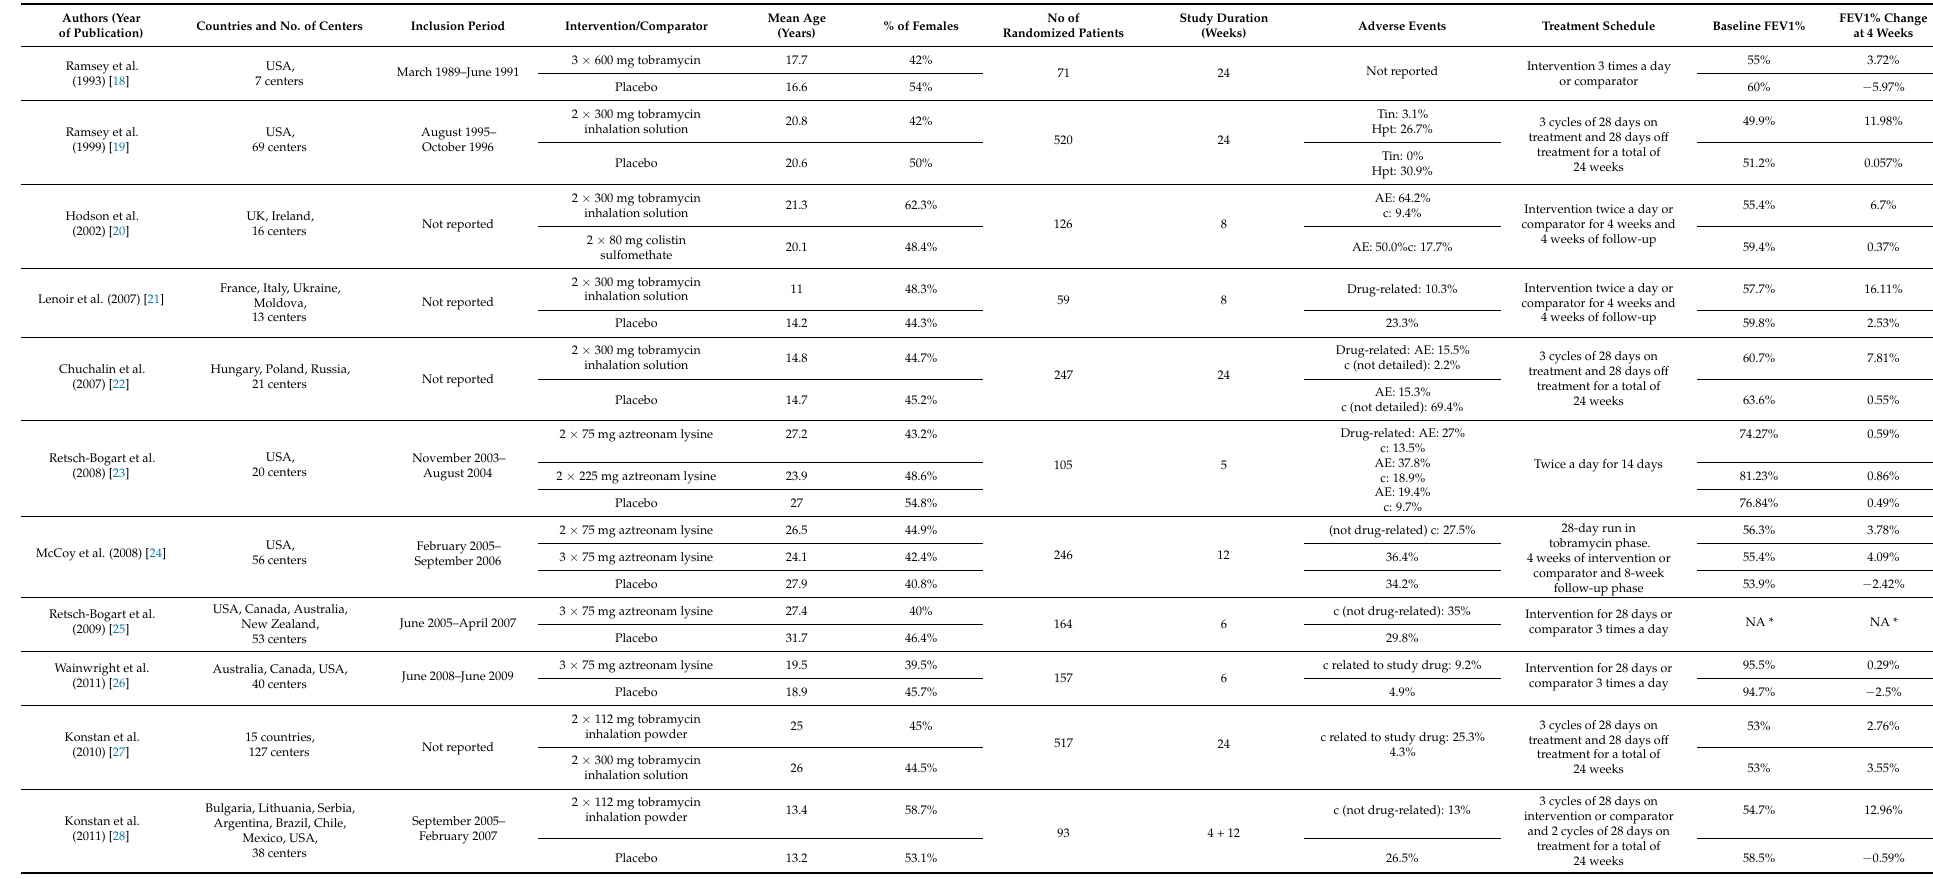
Table 1. Study characteristics, Tin = tinnitus, Hpt = hemoptysis, C = coughing, AE = any adverse event, NA = not applicable (*incomparable unit of measurement), ND = no